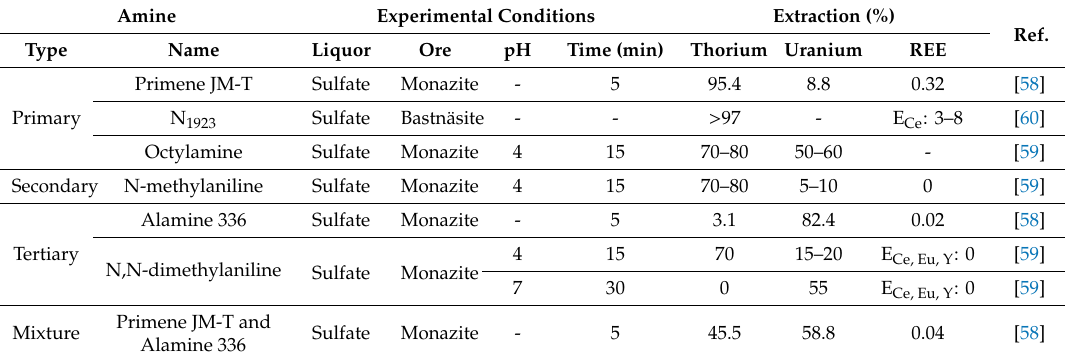
Table 5. Performance of amine extractants for uranium and thorium separation from REE. Amine Experimental Conditions Extraction (%)